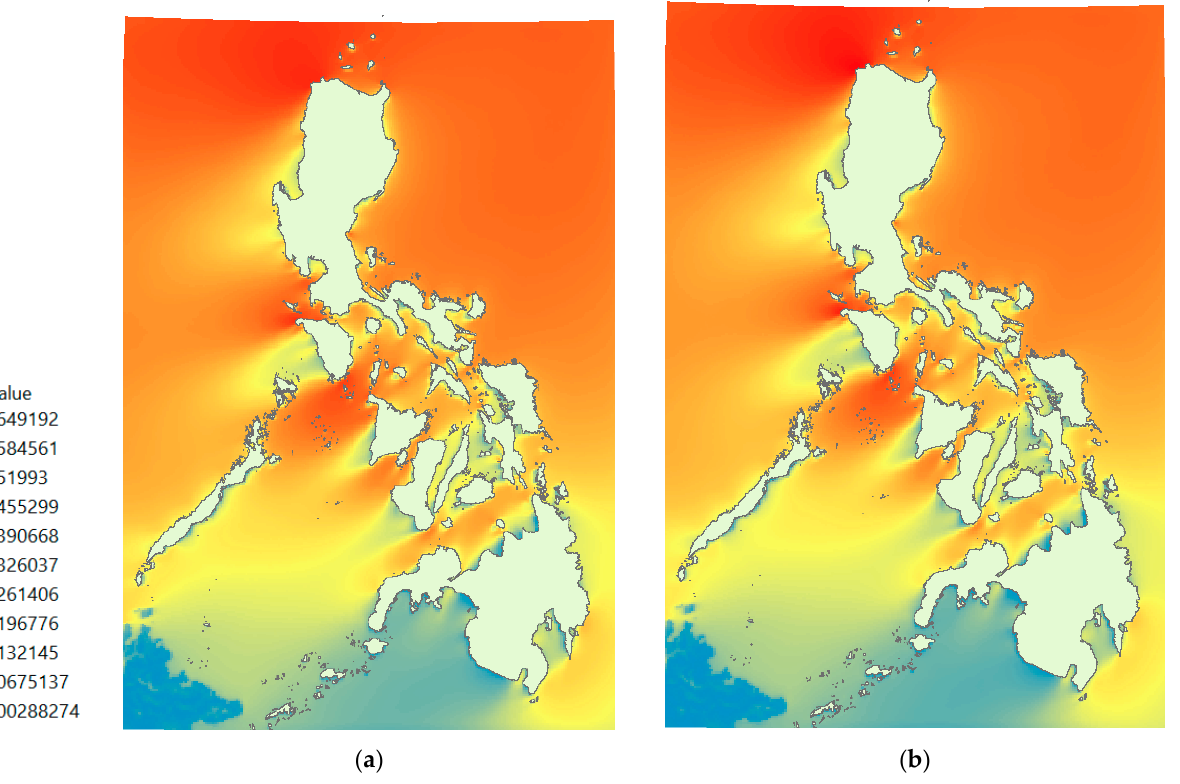
Figure 20. Capacity factor of ( a ) SWT-3.6-120 and ( b ) 6.2M126.